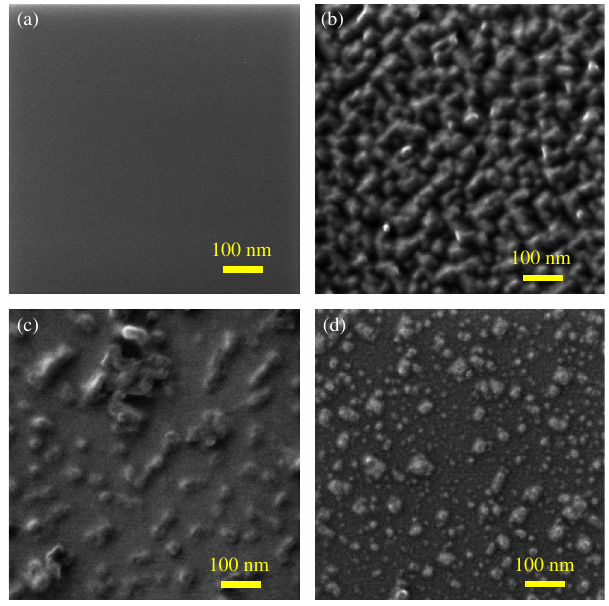
FIG. 2. Comparison of HIM images collected at normal inci- dence from the four FEL photocathode samples: (a) control, (b) control that has been heated as in the photocathode activation procedure, (c) 1000 coulomb sample, and (d) 7000 coulomb